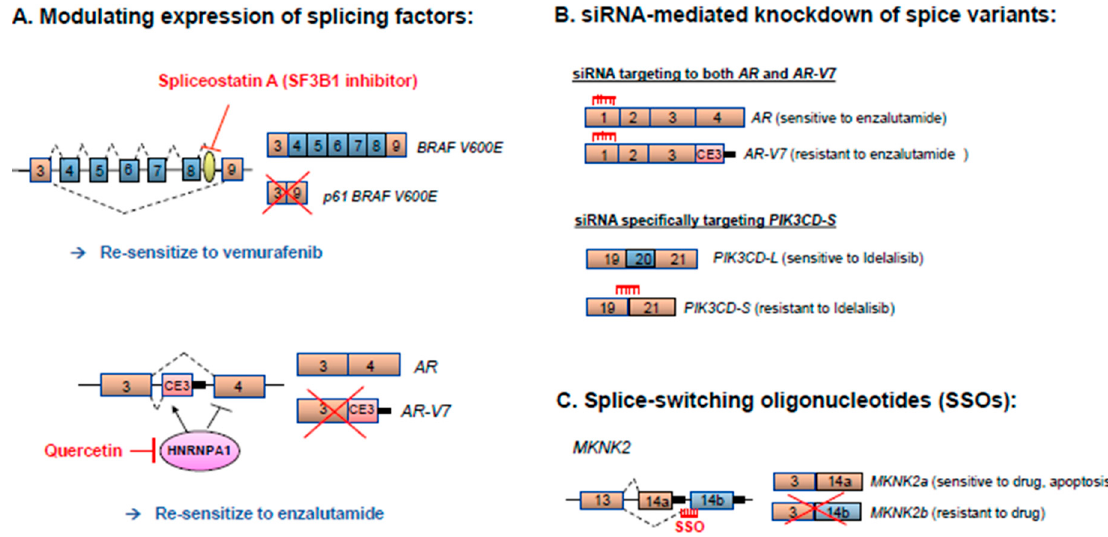
Figure 4. Different re-sensitization approaches to reverse RNA splicing events causing drug resistance. ( A ) Top panel: SiRNA-mediated knockdown of oncogenic splice variants. SiRNAs targeting exon 1of AR-V7 variant. Bottom panel: SiRNA targeting the junction of exons 19 and 21 to specifically inhibit expression of PIK3CD-S . ( B ) Splice switching oligonucleotides (SSO) as a strategy to interfere with aberrant splicing. Example illustrated is an SSO (or splice switching anti-sense oligonucleotide, ASO) bound to the intron-exon junction to prevent splice generation of the MKNK2-2b variant, thereby re-sensitizing cancer cells to drug treatment. ( C ) Pharmacologic inhibition of splicing factors. Spliceostatin A (SF3B1 inhibitor) and quercetin (HNRNPA1 inhibitor) suppress formation of p61 BRAF V600E and AR-V7 splice variants, respectively. These approaches will induce re-sensitization of cancer cells to drug treatments. See text for corresponding